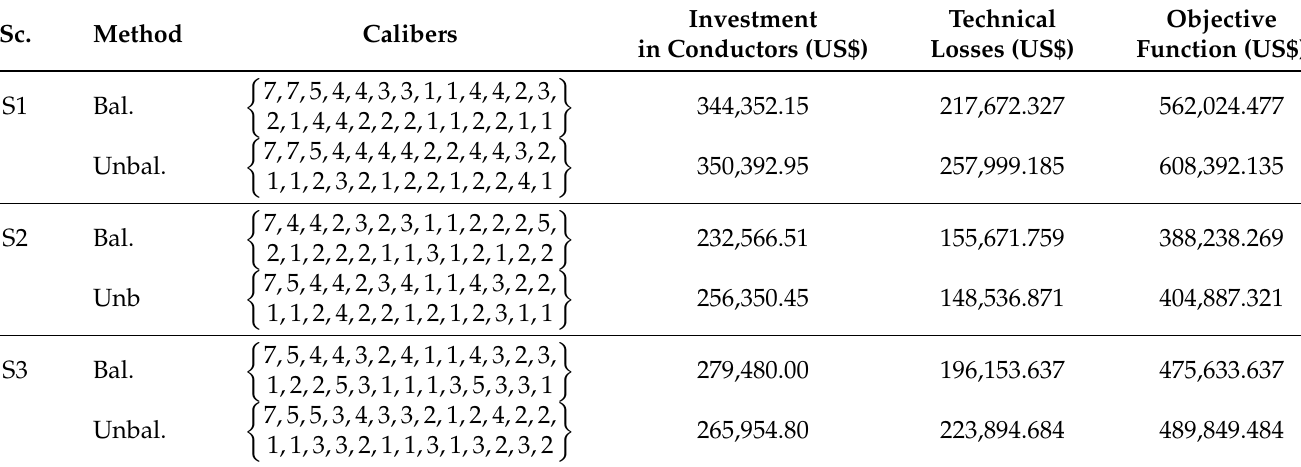
Table 24. Analysis of the 27-bus system with the DVSA approach for Y load connections. Sc.